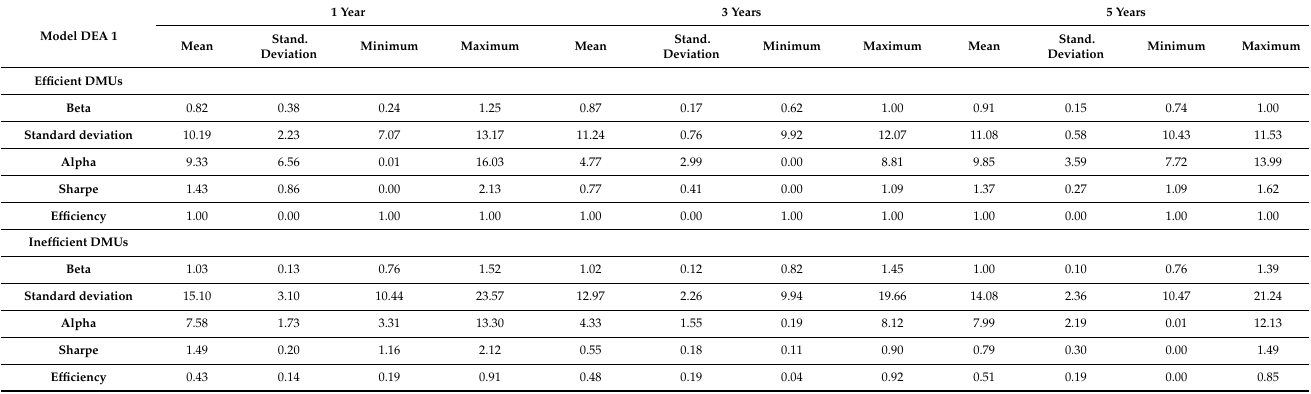
Table A5. Descriptive statistics of efficient and inefficient DMUs in model